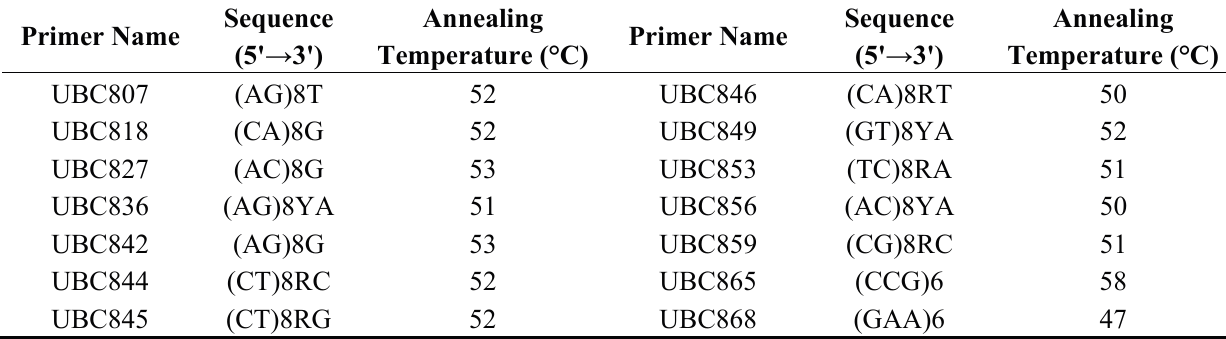
Table 6. ISSR primers used in the present